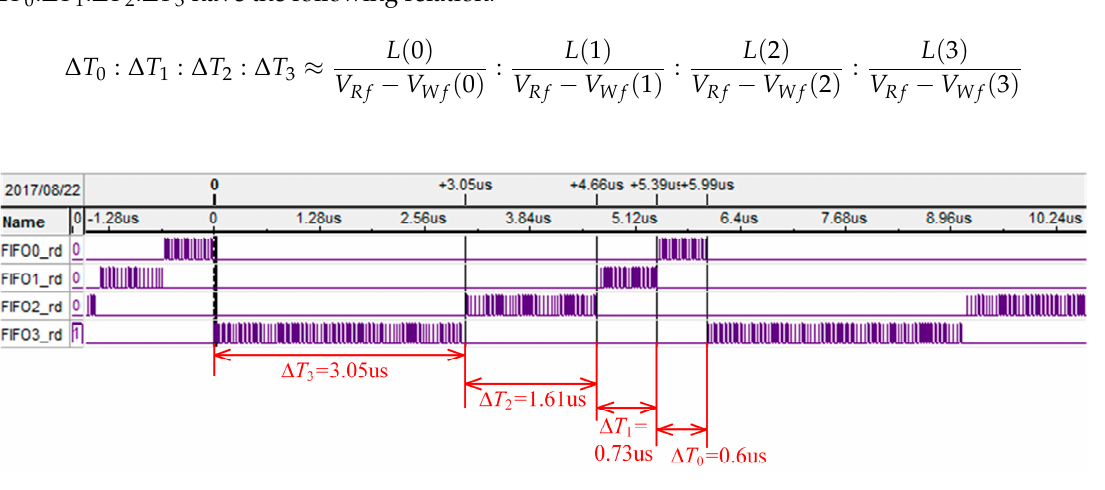
Figure 4. The 4 FIFOs read timing waves of the MFBSS algorithm from Signaltap.